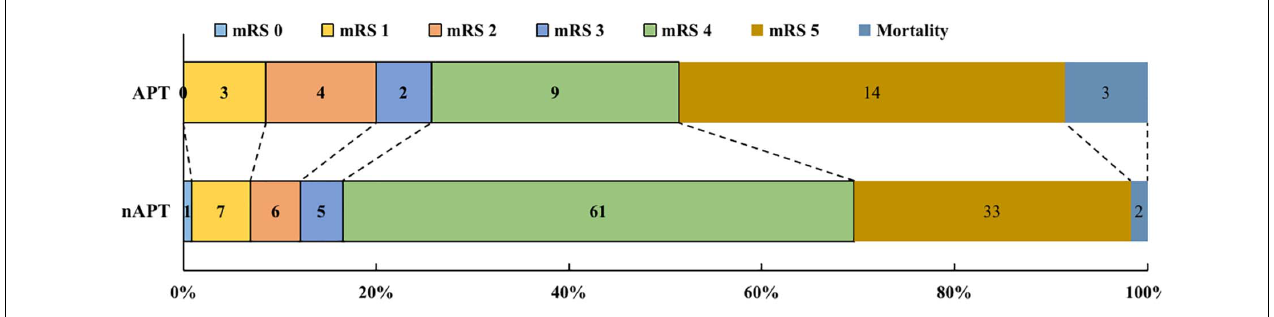
FIGURE 1 | The outcomes of patients with ICH after surgery. APT, antiplatelet therapy; nAPT, no antiplatelet therapy; mRS, modified Rankin Scale.